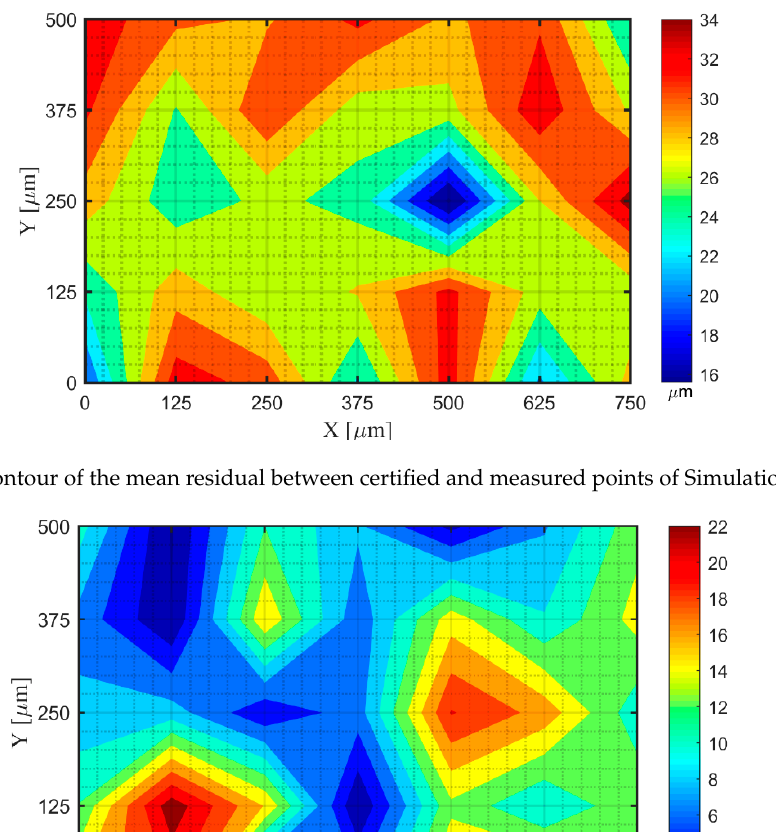
Figure 20. Comparison of the positions of the certified, measured, and corrected points of Simulation No. 10.